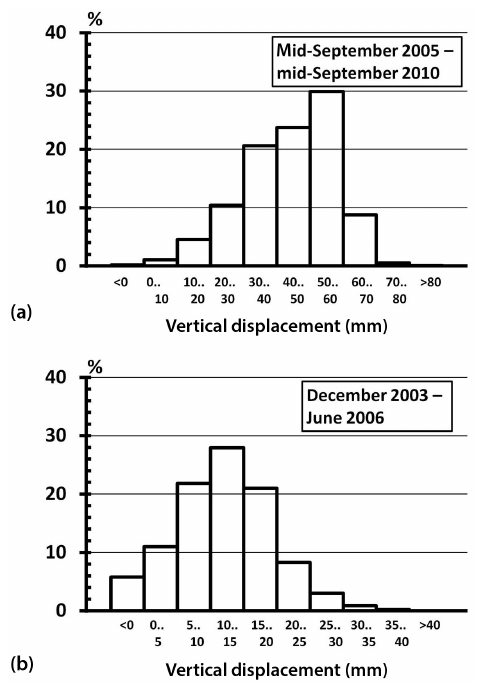
Figure 5. Distribution of total surface movement (inmm): (a) pe- riod 2, 5-year time zone, from mid-September 2005 through mid- September 2010; (b) period 2, 2.5-years time zone, from December 2003 through June 2006. Largest uplift (positive values) is plotted to the right.